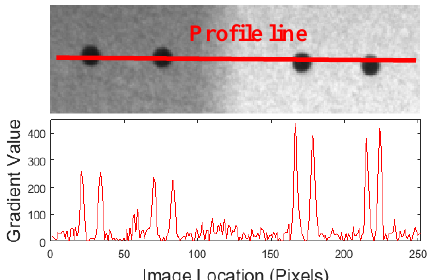
Figure 4. Gradient magnitude profile of four calibration targets (absolute values of gradient magnitude are